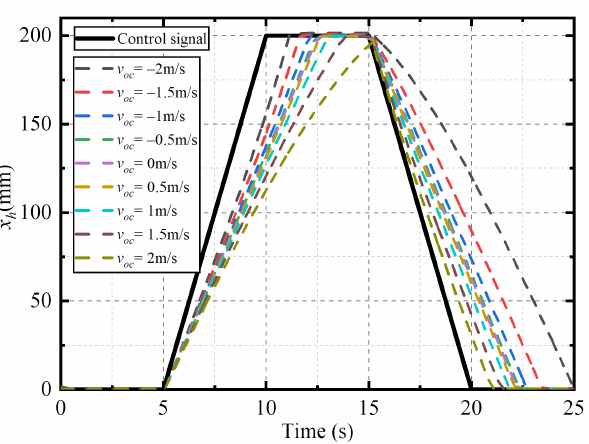
Figure 21. Displacement output, x h , at different velocity of ocean current, v oc , when depth is 11